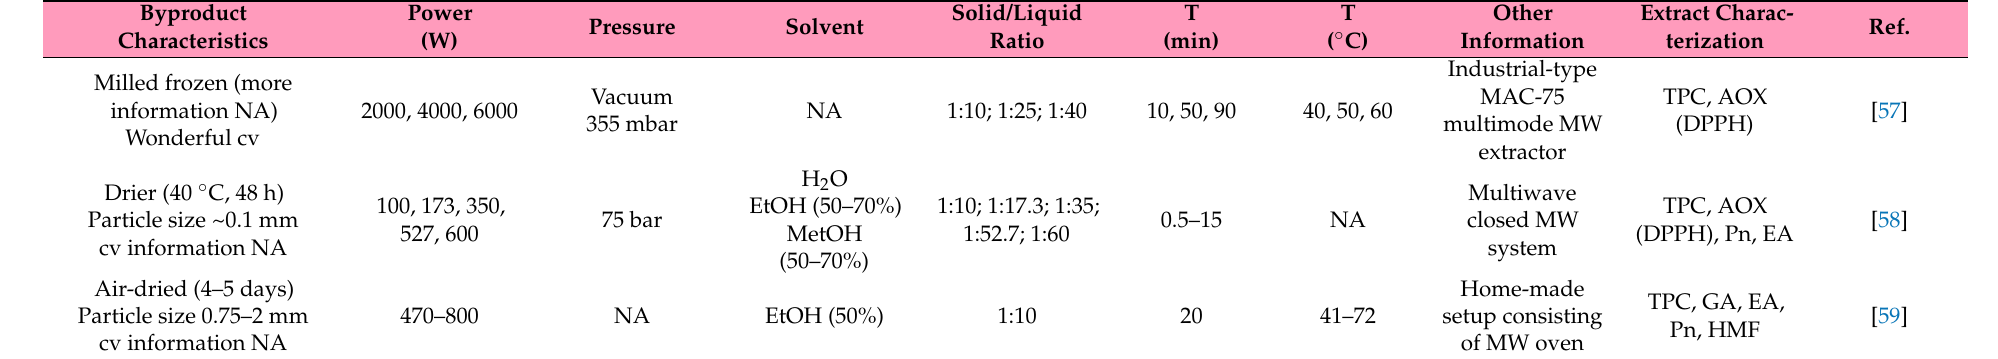
Table 2. Microwave conditions (power parameters, solvent, time, temperature) for the extraction of bioactive compounds from pomegranate peel.